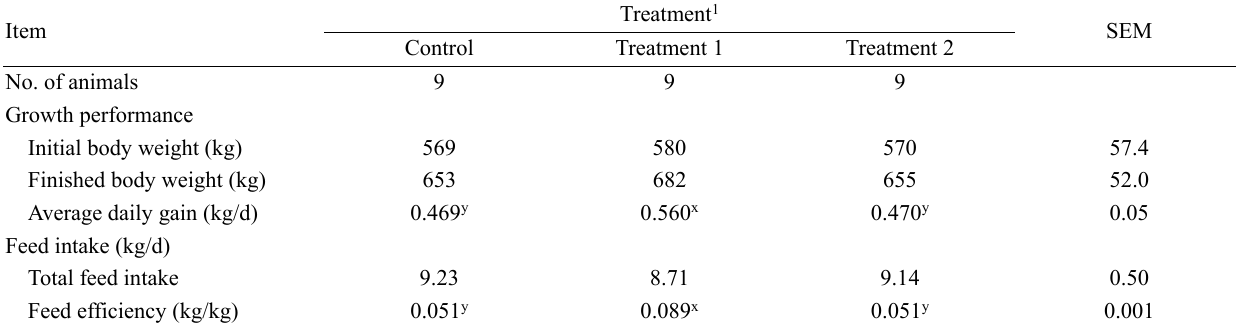
Table 3. Substitution effect of a total mixed ration by medicinal plant by-products on growth and feed efficiency in the late fattening period of Hanwoo